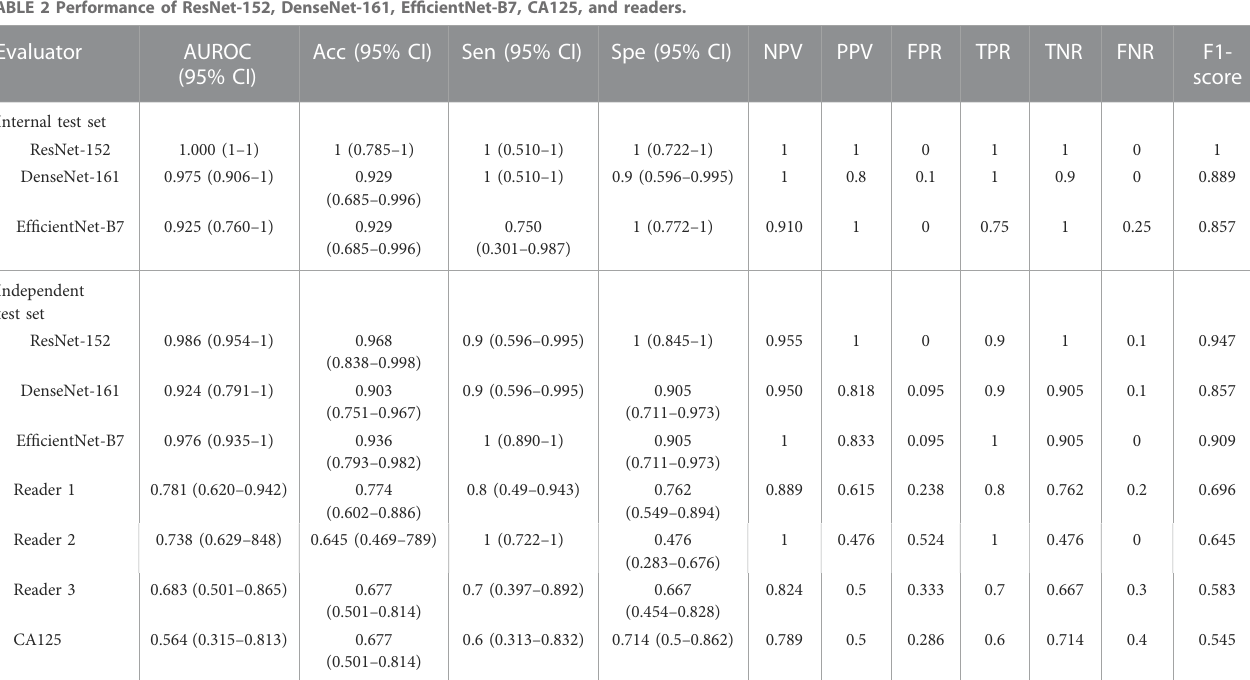
Table 2, on the independent test set, the AUROCs, accuracy, sensitivity, speci fi city, TPR, FPR, TNR, and FNR were only 0.781